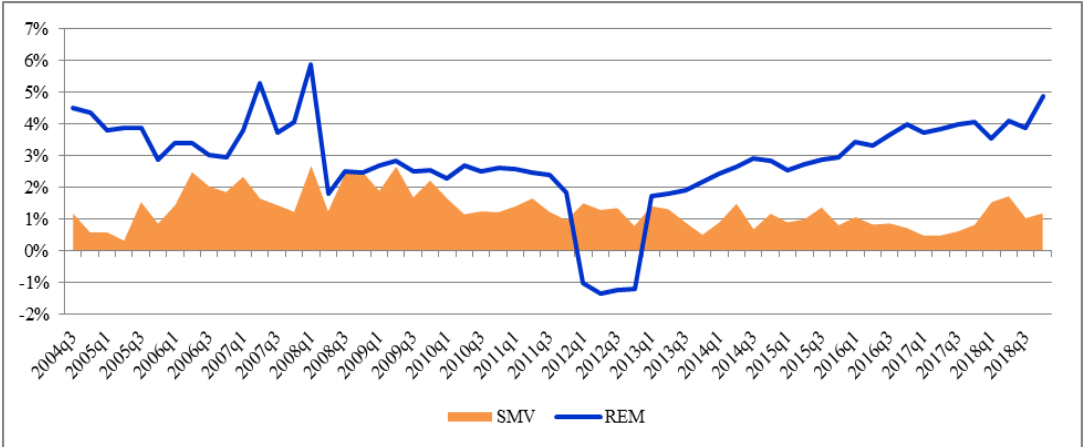
Figure 8. The real estate market and stock market volatility in